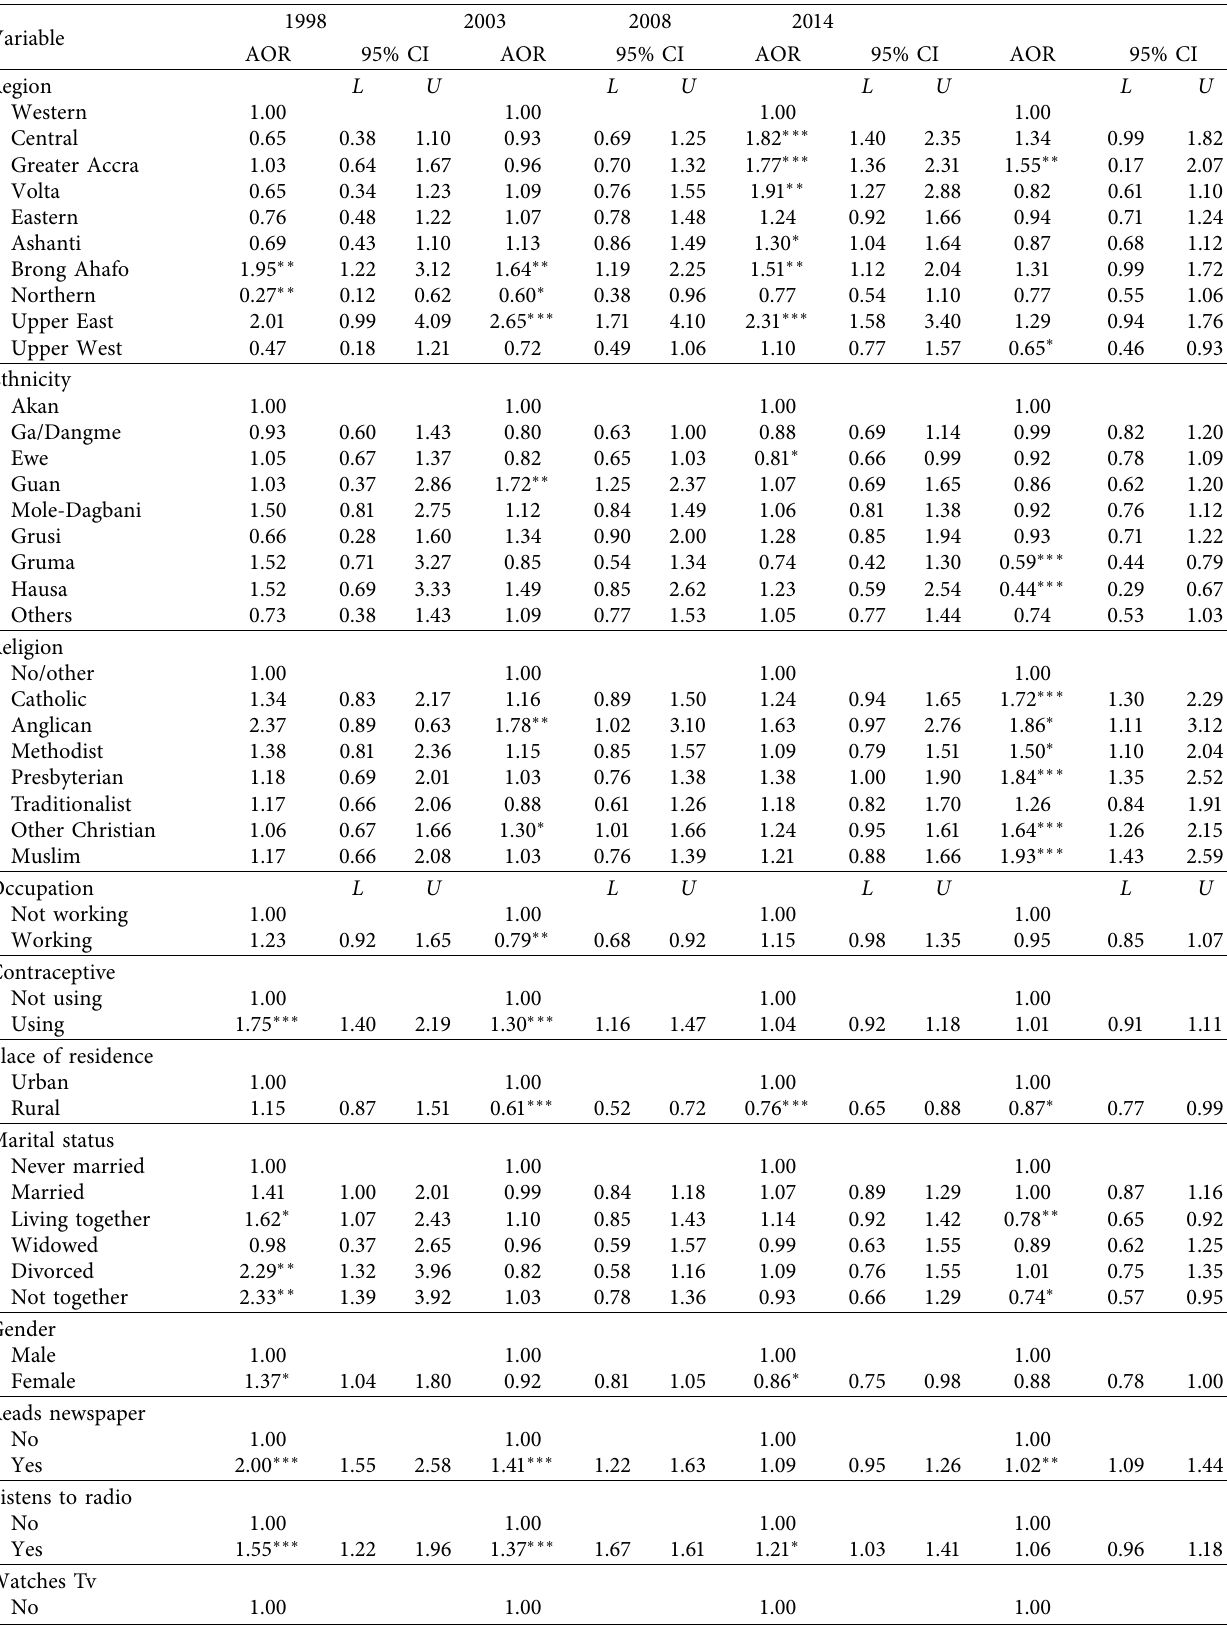
Table 4: Adjusted odds ratio of comprehensive knowledge of HIV and AIDS among Ghanaians